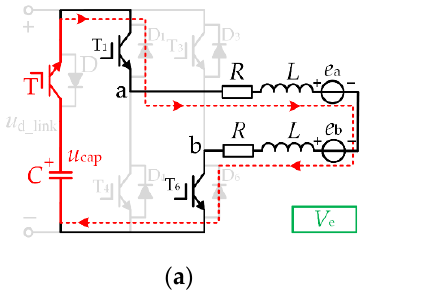
Figure 6. Vector equivalent circuit ( a ) V e ( b ) V 0 .